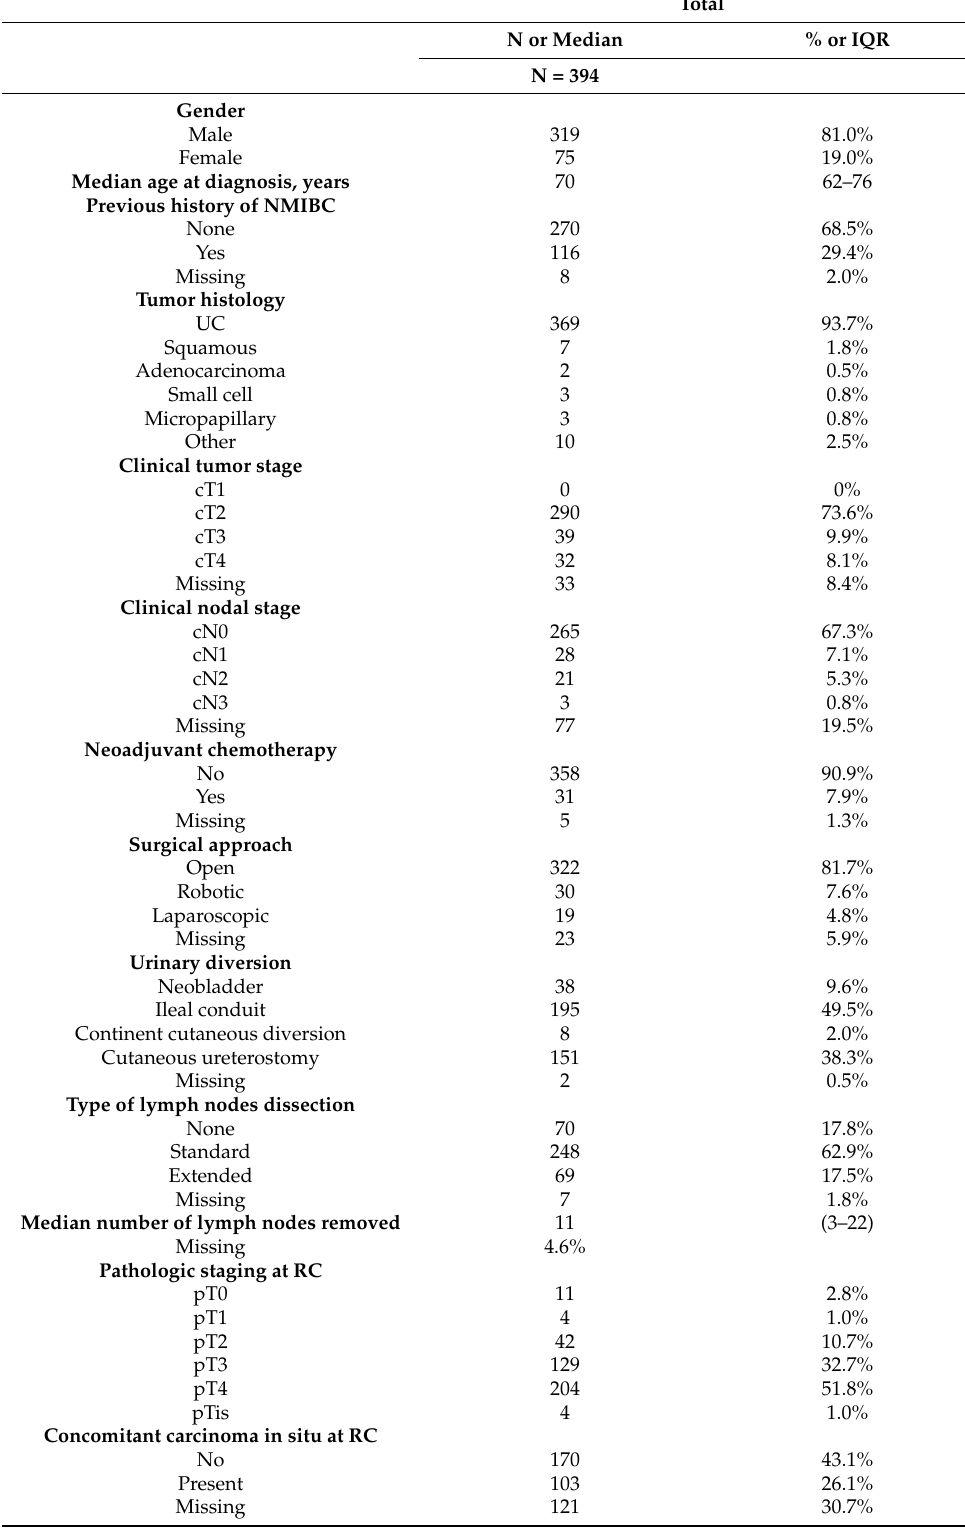
Table 1. Patient demographics and clinical and pathological